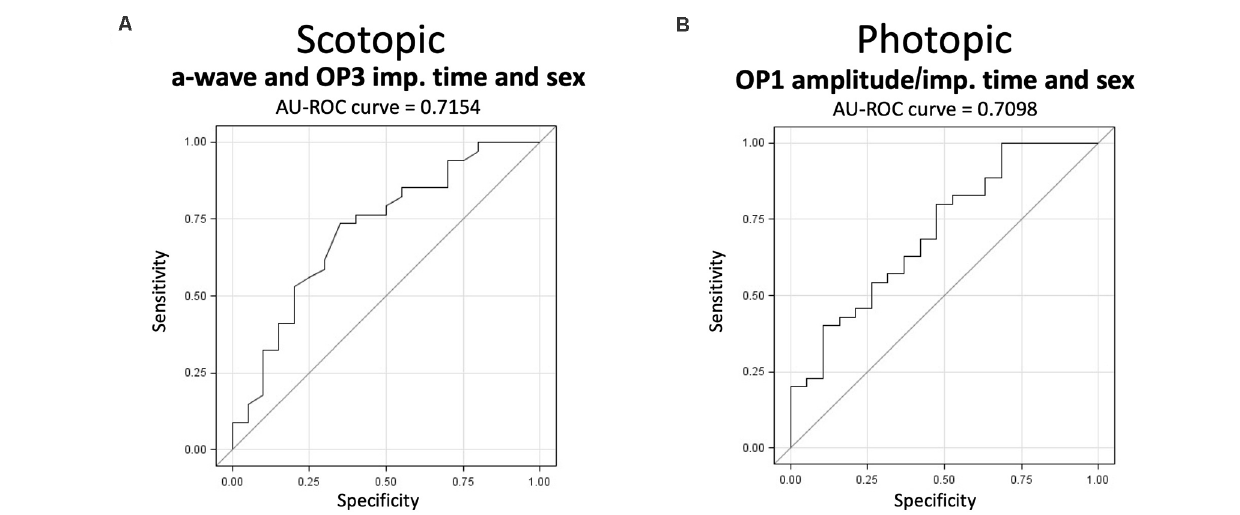
FIGURE 8 | The capacity of the scotopic and photopic ERGs to predict the expression of stress susceptibility and resilience from baseline signals. (A) The scotopic model fitting the scotopic a-wave and third OP implicit time with sex has an AU-ROC curve of 0.7154 ( p < 0.05). (B) The photopic model fitting the first photopic OP amplitude and implicit time with sex has an AU-ROC curve of 0.7098 ( p < 0.05). Statistical significance was determined using multiple backward logistic regressions and was set at p < 0.05; n -values are given in the “Materials and Methods”